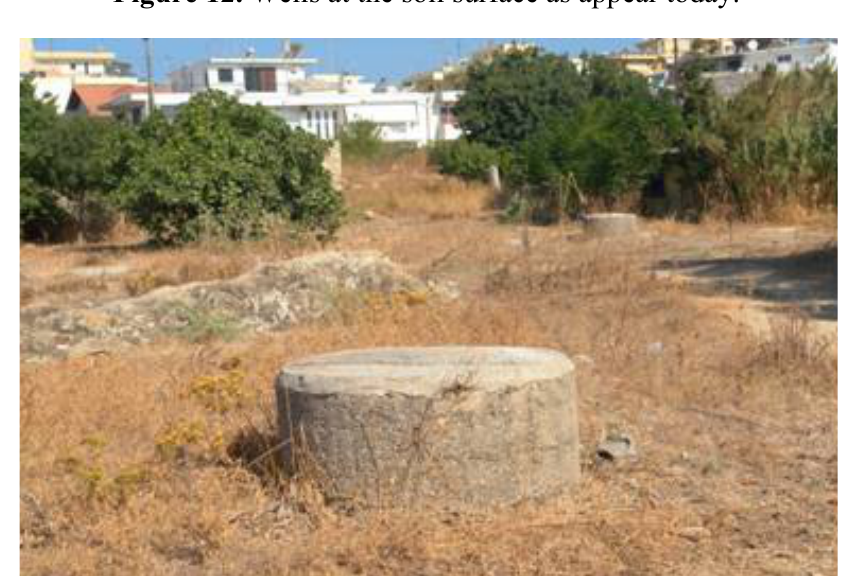
Figure 12. Wells at the soil surface as appear today.